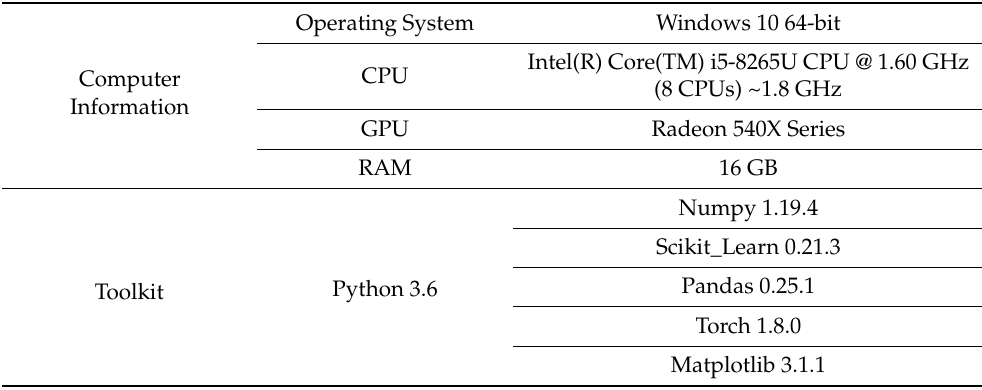
Table 1. Experimental platform and environmental